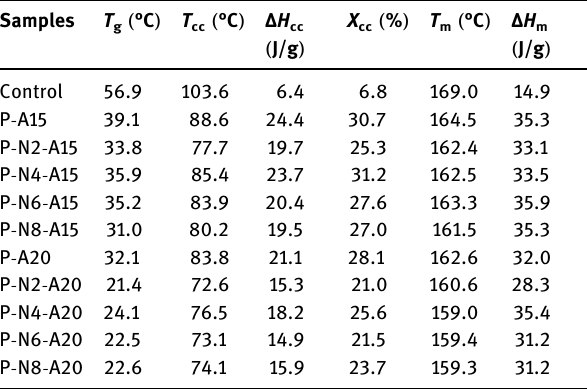
Table 2: DSC parameters of the PLA/NFC composites